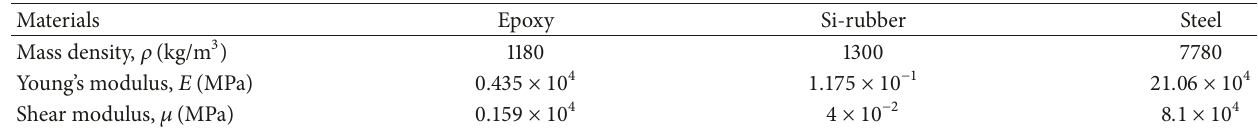
Table 2: Mass densities and elastic constants of the